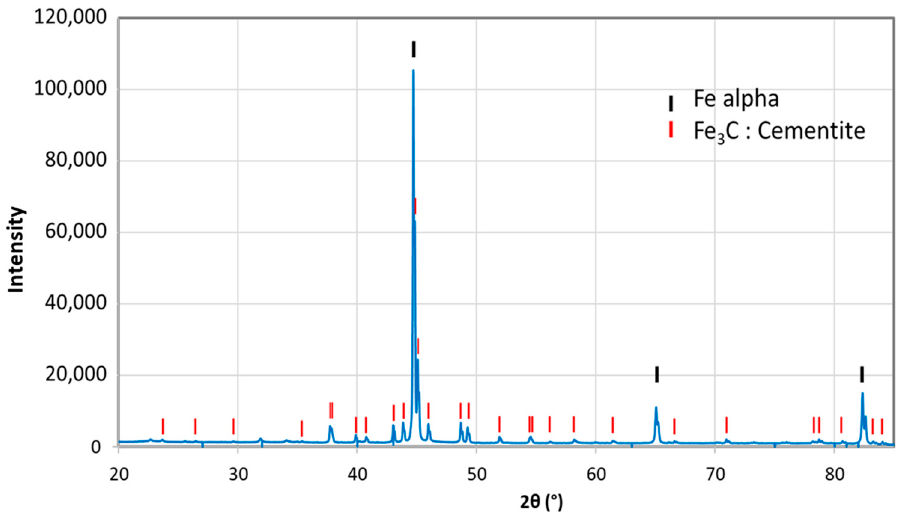
Figure 2. X-ray diffractometry (XRD) analysis of 7-day-exposed coupon in CO 2 saturated condensate containing H 2 SO 4 0.114 M and HNO 3 0.0184 M.